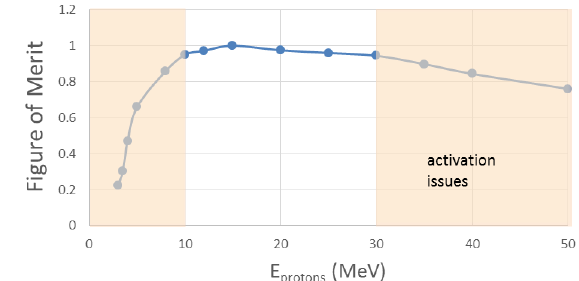
Fig. 4. Figure of merit defined as [Neutron Flux / Cost]